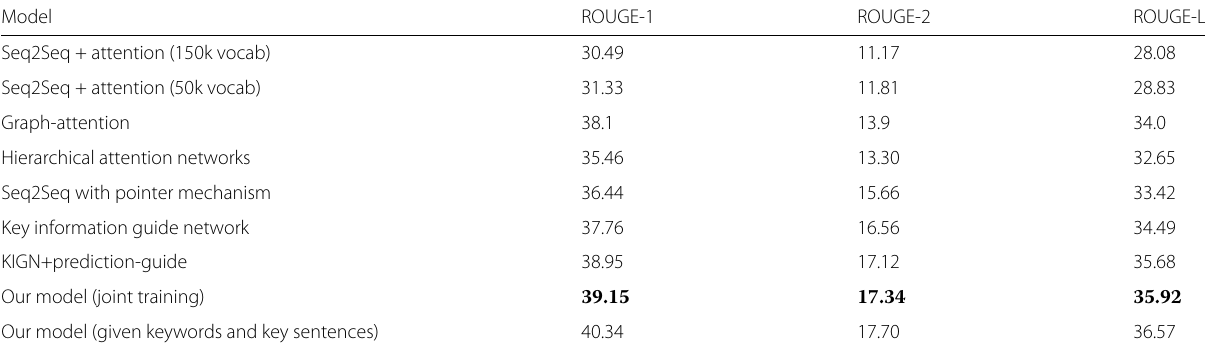
Table 1 ROUGE F1 scores for models on the CNN/Daily Mail test set Model Seq2Seq + attention (150k